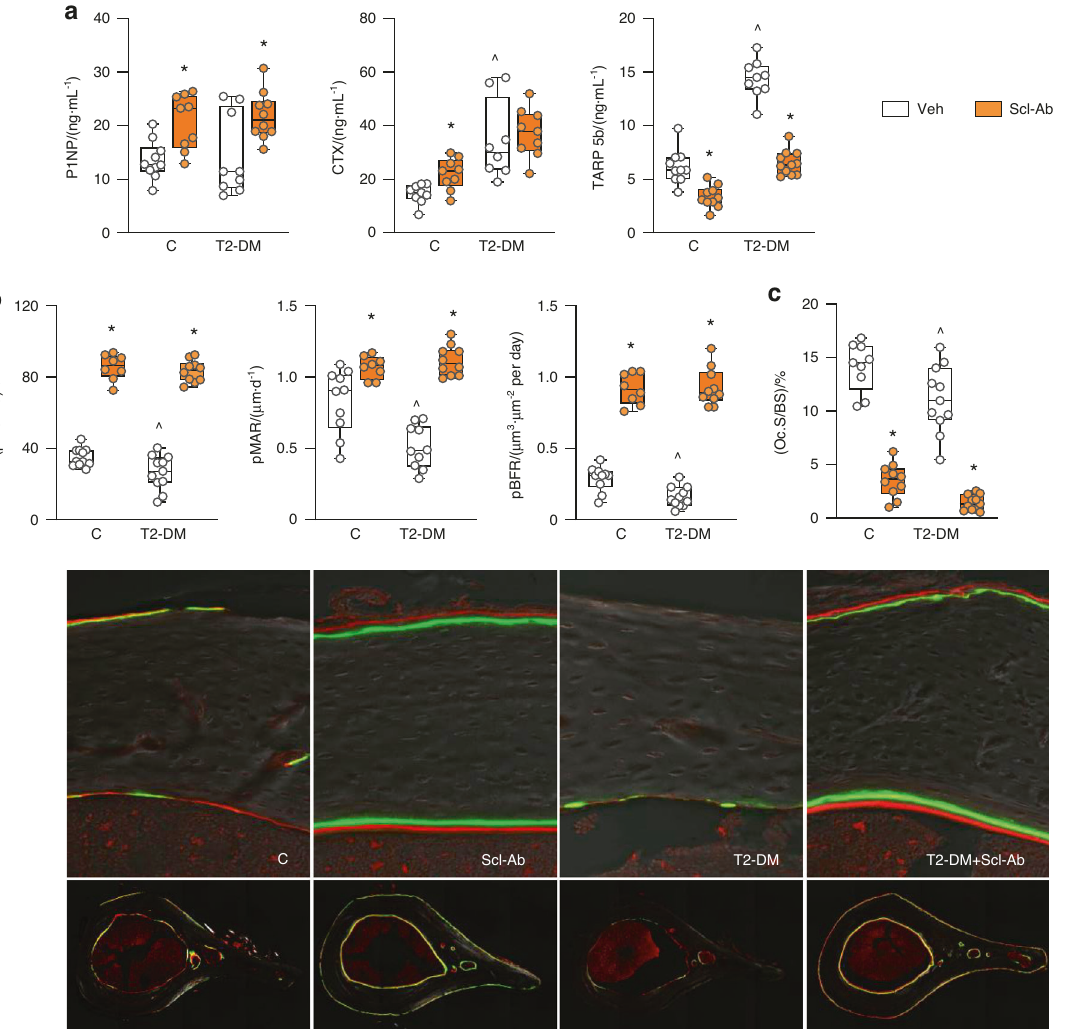
Fig. 7 Scl-Ab increased bone formation, inhibited bone resorption and reversed the impaired osteoblast function in diabetic mice. a P1NP, CTX, TRAP 5b measure after treatment with Scl-Ab in C and DM mice. b Dynamic bone histomorphometric analysis of mineralized surface/ bone surface (MS/BS), mineral apposition rate (MAR) and bone formation rate (BFR) at the periosteal surface of the cross-section of the femoral mid-diaphysis after treatment with Scl-Ab in control and DM mice and representative images. c Surface covered by osteoclasts (OcS/BS). For all analyses, n = 10 – 12 mice per group. Data are presented as box & whisker plot where each dot represents a mouse. ^ P < 0.05 versus control LFD mice and * P < 0.05 versus respective vehicle-treated mice by two-way ANOVA with post hoc Bonferroni ’ s correction for multiple